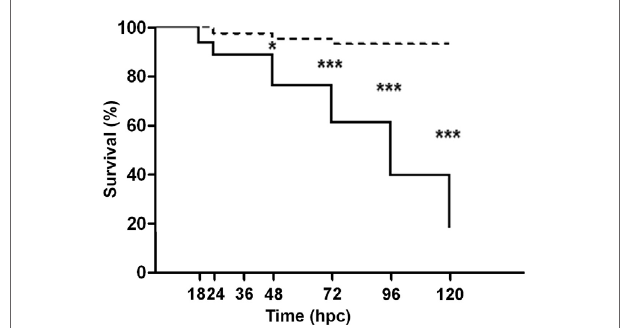
FigUre 2 | Cumulative survival of full-sibling sea bass larvae challenged with Vibrio anguillarum . The mortality (mean ± SE) is represented in each time [hours post-challenge (hpc)] for non-challenged (dashed line) and challenged group (continuous line). Significant differences (linear regression model with Bonferroni posttest) are shown with asterisks (* p < 0.05; *** p <